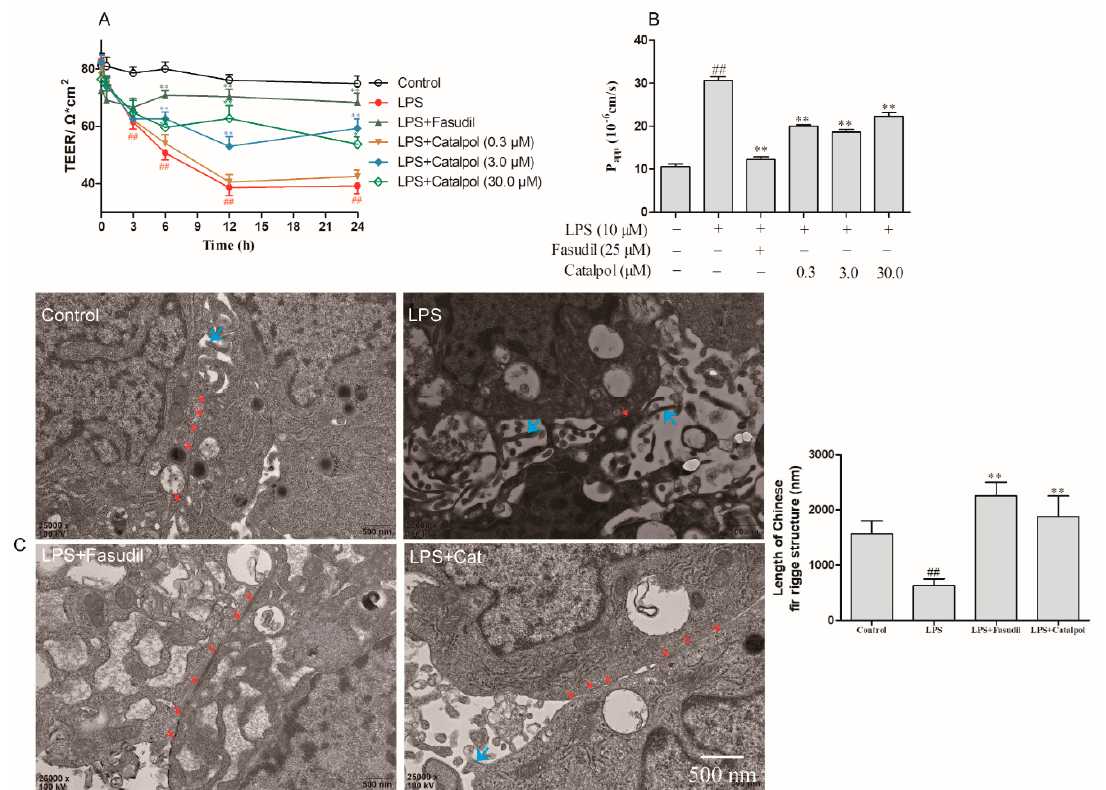
Figure 5. The protective effects of catalpol on TEER, fluorescein sodium transmittance, and tight junction of BMEC. ( A ) Catalpol (3.0 and 30.0 µ M) increases LPS-induced reduces of TEER ( Ω · cm 2 ). ( B ) Catalpol (0.3, 3.0 and 30.0 µ M) reduces LPS-induced increase of the transmittance of fluorescein sodium (Papp, 10 − 6 cm/s). ( C ) Catalpol (3.0 µ M) improves LPS-induced injury of tight junction as detected by transmission electron-microscopy. Red arrows, the tight junction (Chinese fir ridge structure) between BMECs; Blue arrows, plasma membrane protrusions. ## p < 0.01 vs. the control group; ** p < 0.01, vs. the model group. ( ± SD, n =